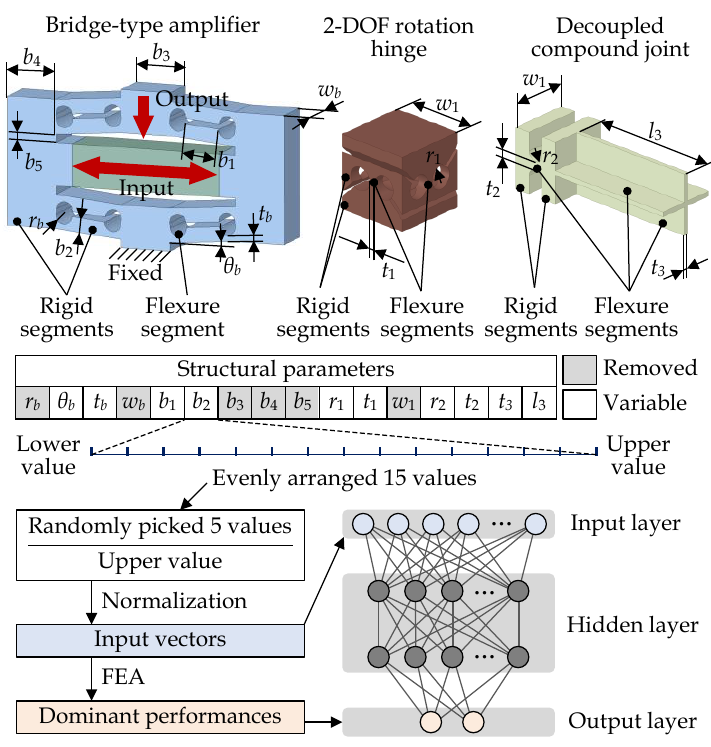
Figure 3. FEA-based neural network model.